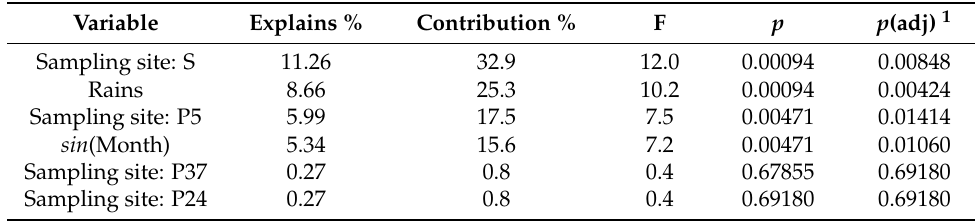
Table 1. Descriptive statistics of